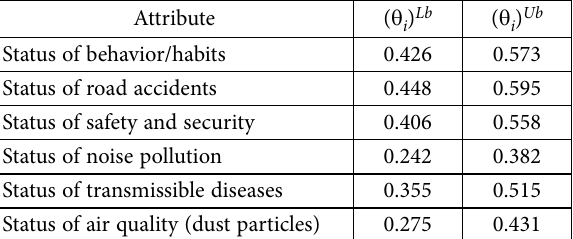
Table 11. Lower and upper bound values for the attribute